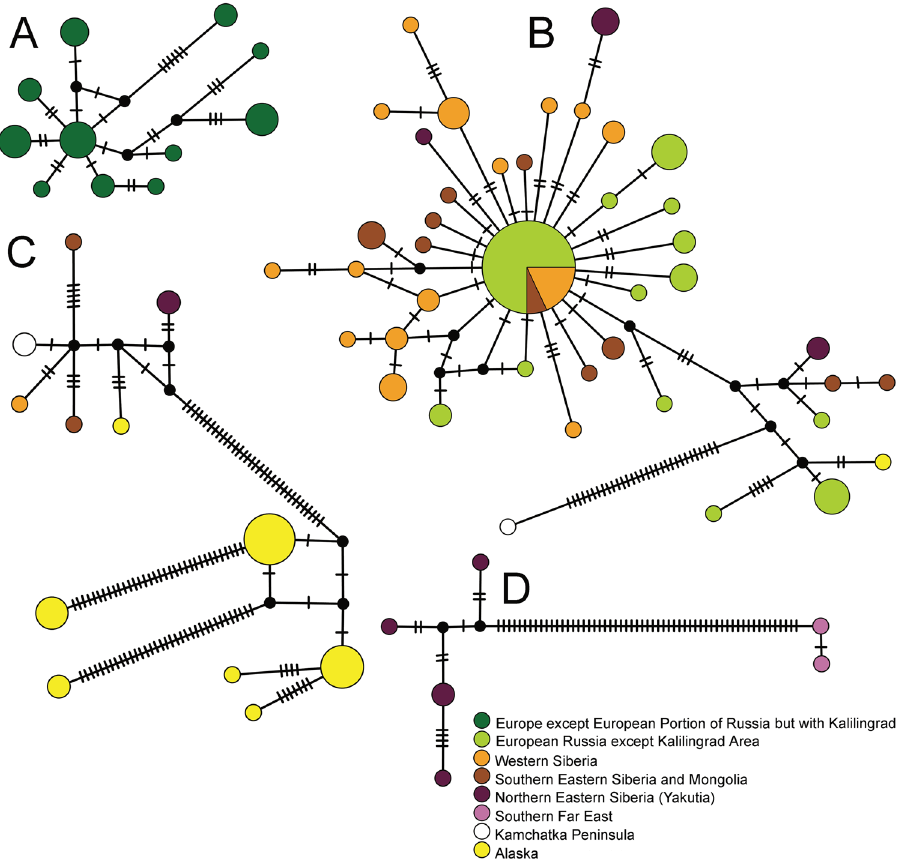
Figure 5. Median-joining haplotype networks of mitochondrial clades for neustonic daphniids in the Scapholeberis mucronata group. Bold letters indicate geographic clades (see Fig. 2). Pie diameter indicates the frequency of the haplotype and substitutions among haplotypes are depicted by hash